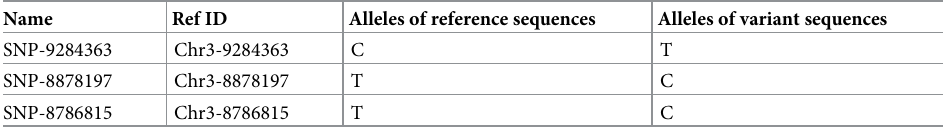
Table 3. Information of 3 male-specific SNP obtained from Alosa sapidissima .